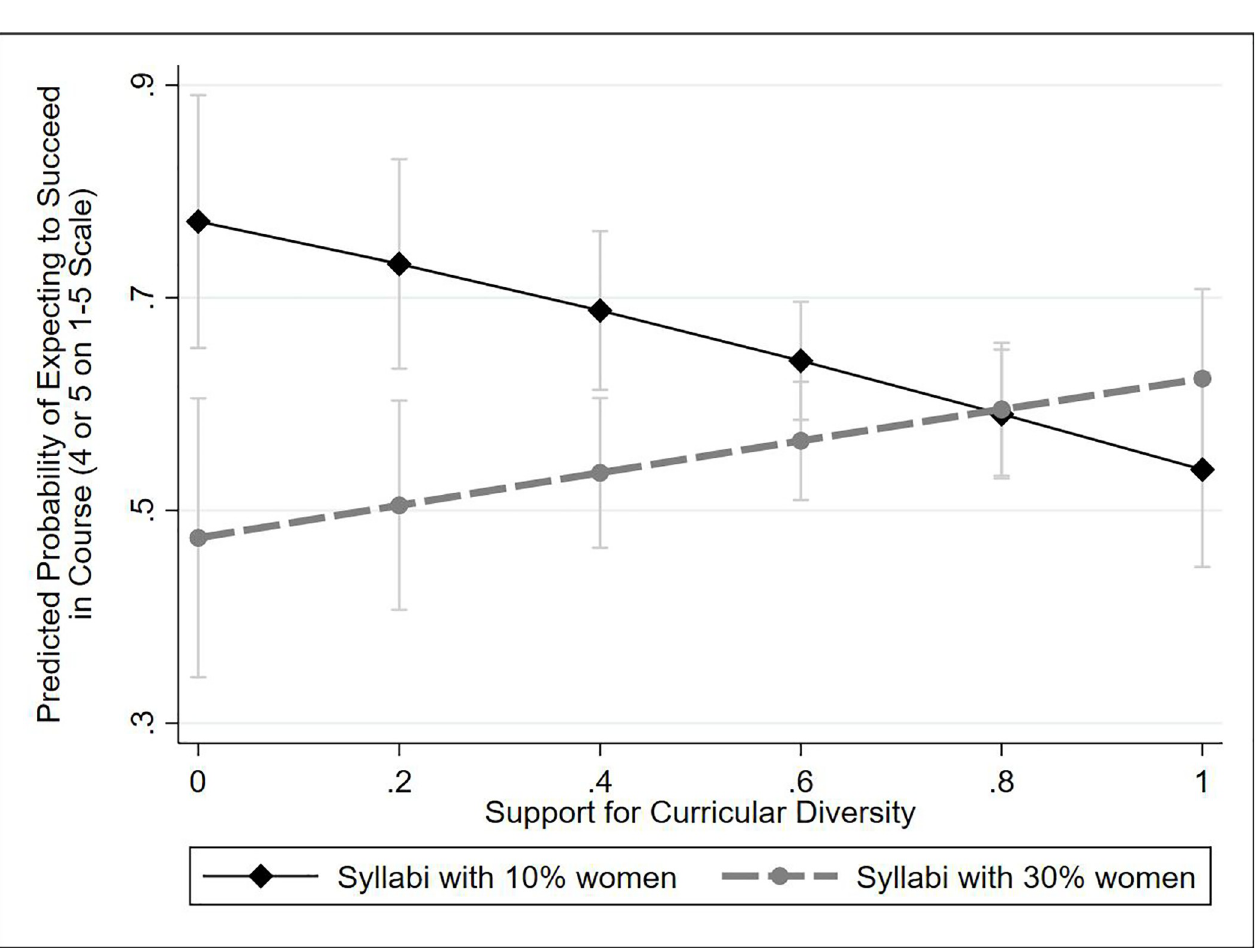
Fig 2. Impact of attitudes toward diversity on students’ responses to a gender-diverse syllabus. Results are from a logistic regression model predicting perceived likelihood of success in the course (coded as reporting a 4 or a 5 on a 1–5 scale), controlling for gender as well as orientations toward quantitative and qualitative methods, which are correlated with both gender and course-related self-efficacy (see S1 File for further discussion). The figure shows 84% confidence intervals; visual comparison of two 84% CIs is equivalent to a single 95% test [64, 65].